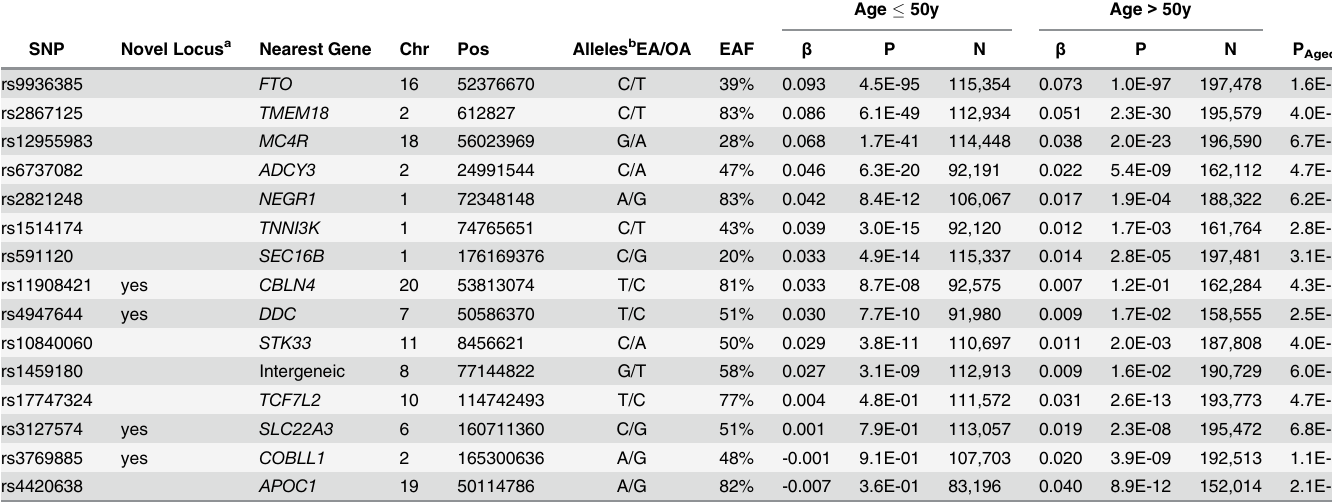
Table 1. Fifteen BMI loci showing significant age-differences in adults (cid:3) 50y compared to adults > 50y. The table shows the age-group specific (sex- combined) results, ordered by largest to smallest effect in adults (cid:3) 50y. All loci were detected by the screen on age-difference that included the a-priori filter on P Overall < 10 − 5 . The age- and sex-specific results (four strata) and more detailed information on the loci are given in S4 Table